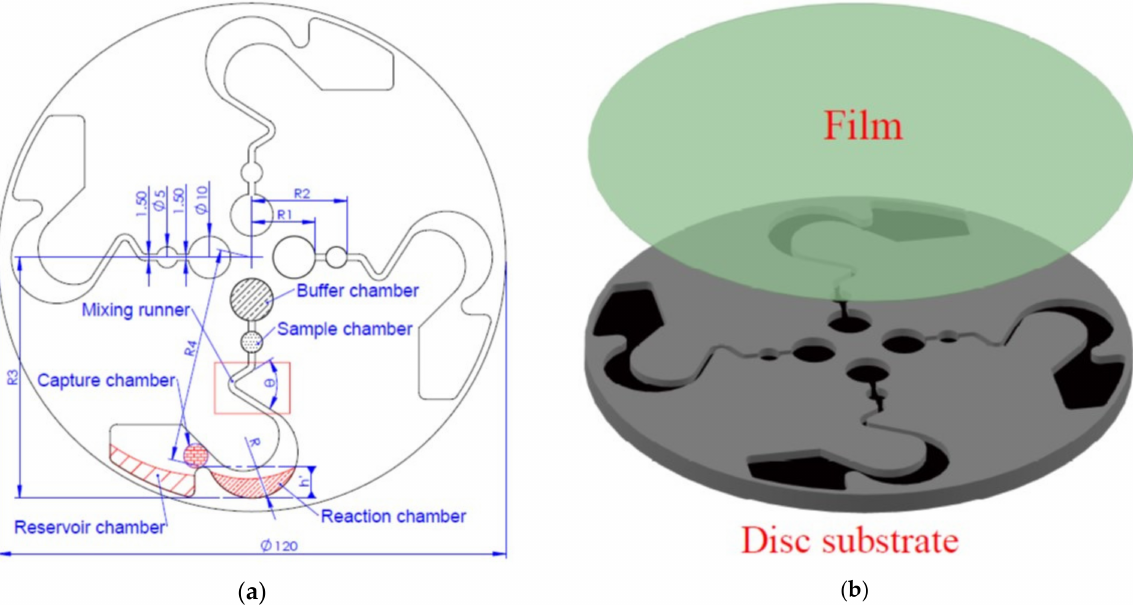
Figure 1. Design of the disc pattern. ( a ) Disc pattern design and labelled chamber locations. ( b ) Disc is assembly by film and disc